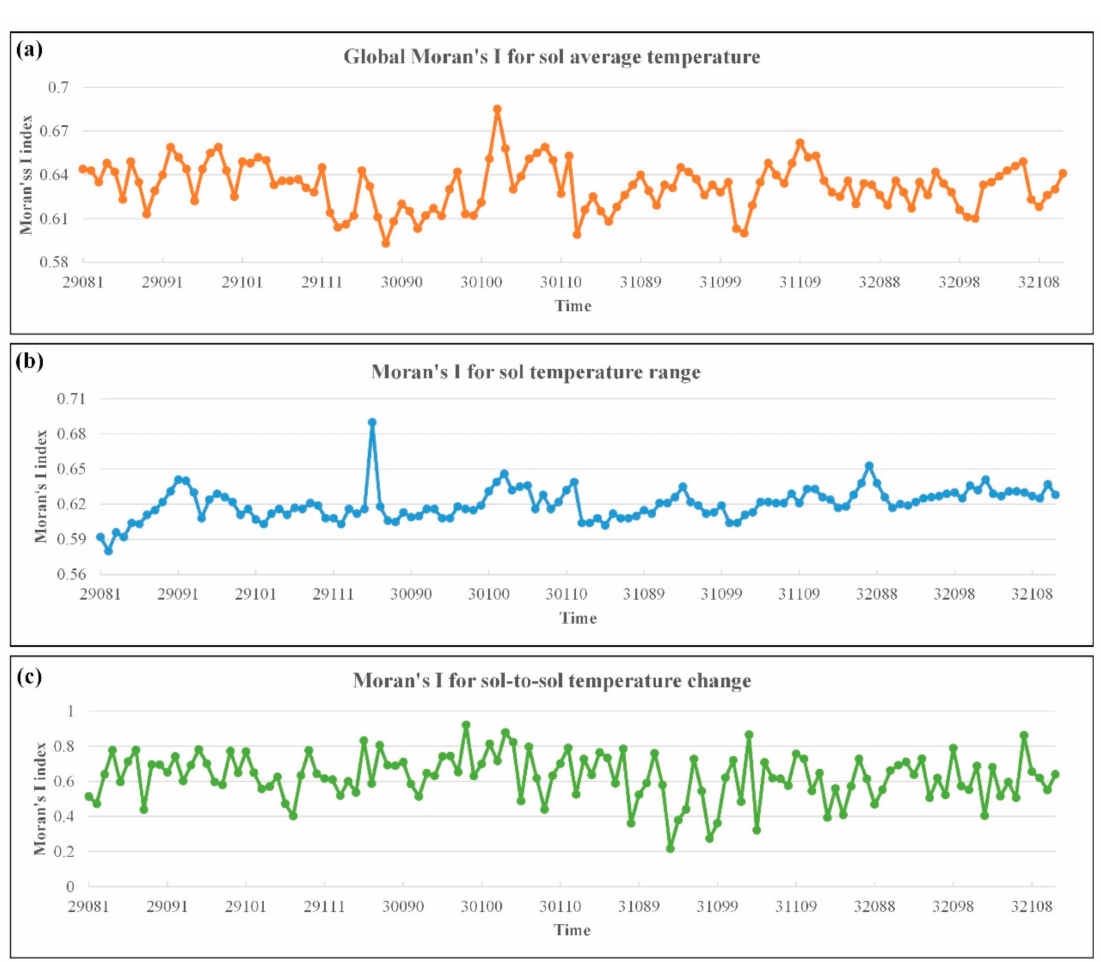
Figure 5. The trend in global spatial autocorrelation ( p < 0.001) for sol average temperature ( a ), sol temperature range ( b ), and sol-to-sol temperature range ( c ) during sol 81–111 from Martian years 29 to 32 in the study